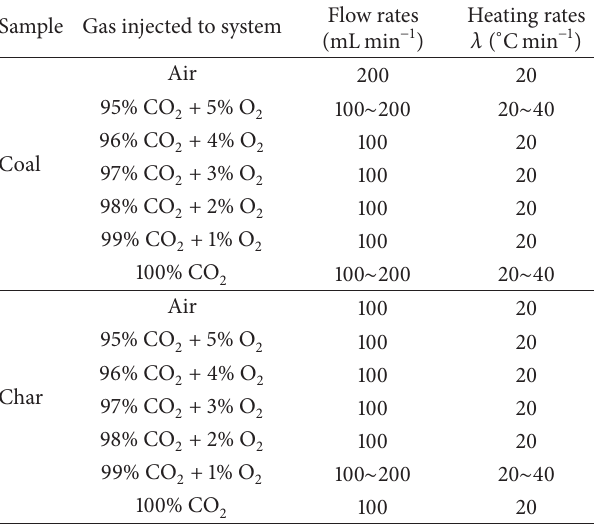
Table2:Experimentalconditionsoftemperaturesandgasflowrates for the TG-DTA analysis. Sample Gas injected to